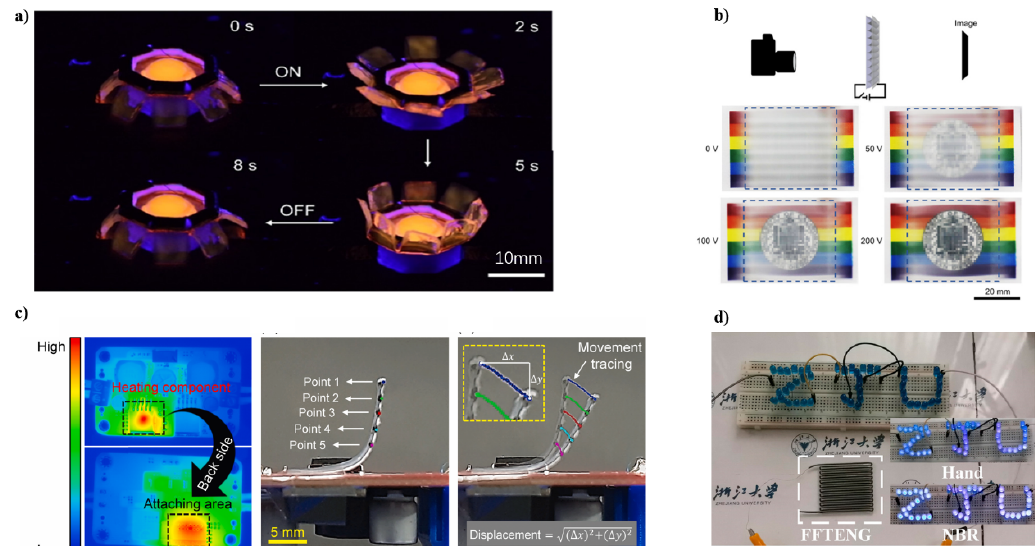
Figure 4. ( a ) Photograph of a printed PVC gel jellyfish actuator with 1000 V applied. Add the fluorescent dye Rhodamine B to the ink for visualization. Photos were taken in dark conditions and 365 nm UV light. Reproduced with permission from ref. [63]. Copyright 2021, American Chemical Society. ( b ) Voltage can change image transparency. When the applied voltage was increased from 0 V to 200 V, the image behind the PVC gel-based smart window changed from completely opaque to transparent. Reproduced with permission from ref. [63]. Copyright 2021, American Chemical Society. ( c ) Temperature distribution of the electrical DC-DC converter module (shown on the left) The middle image shows five points on the side of the actuator, spaced 2 mm apart. The image on the right shows real-time five-point motion tracking to estimate the position of the actuator at a specific time during the heating process. Reproduced with permission from ref. [64]. Copyright 2021, Elsevier. ( d ) Self-power LED when tapped by bare hand and a NBR-covered hand. Reproduced with permission from ref. [65]. Copyright 2021,